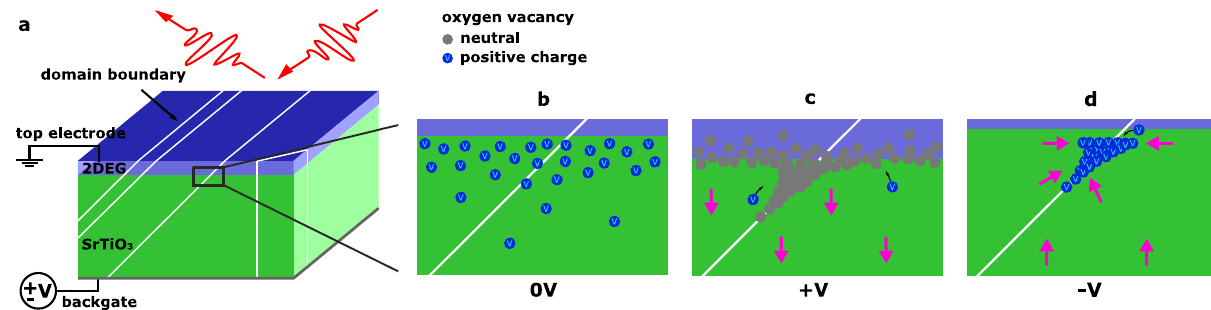
Fig. 2 Schematic of the interfacial electric fi eld. a Sketch of a SrTiO 3 -based heterostructure and the gating between the grounded two-dimensional electron gas (2DEG) and a backside contact. White lines show the antiferrodistortive (AFD) domain boundaries that develop below the AFD transition at T* ≈ 105 K. b Magni fi ed view of the interfacial region at 0 V with the 2DEG (purple shading) and positively charged oxygen vacancies (blue dots) that accumulate near the interface but are still randomly distributed. c At positive gate bias ( + V), the positively charged oxygen vacancies migrate toward the interface and cluster at the AFD domain boundaries. Concurrently, the 2DEG expands and some of the electrons get trapped by the oxygen vacancies which become charge neutral (gray dots). The induced polarization (magenta arrows) is perpendicular to the interface. d At negative backgate voltage ( − V), the 2DEG is more strongly con fi ned to the interface and the electrons get detrapped from the oxygen vacancies which thus regain a positive charge. The local fi elds have now a strong horizontal